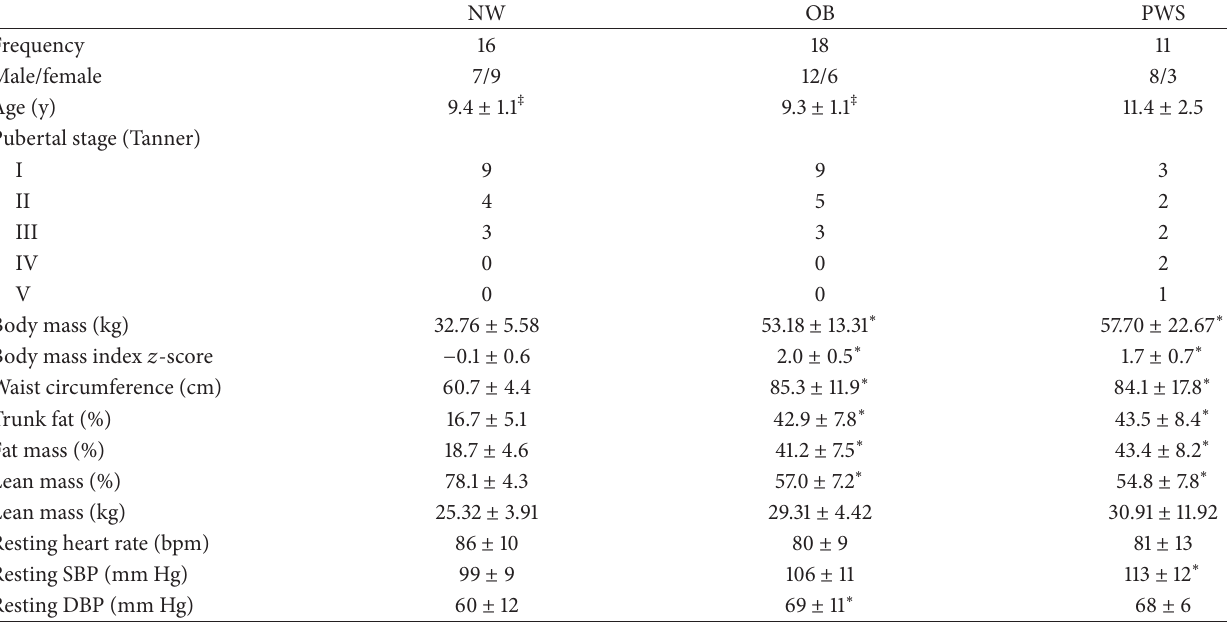
Table 1: Participant demographics and characteristics, presented as frequencies and mean ±